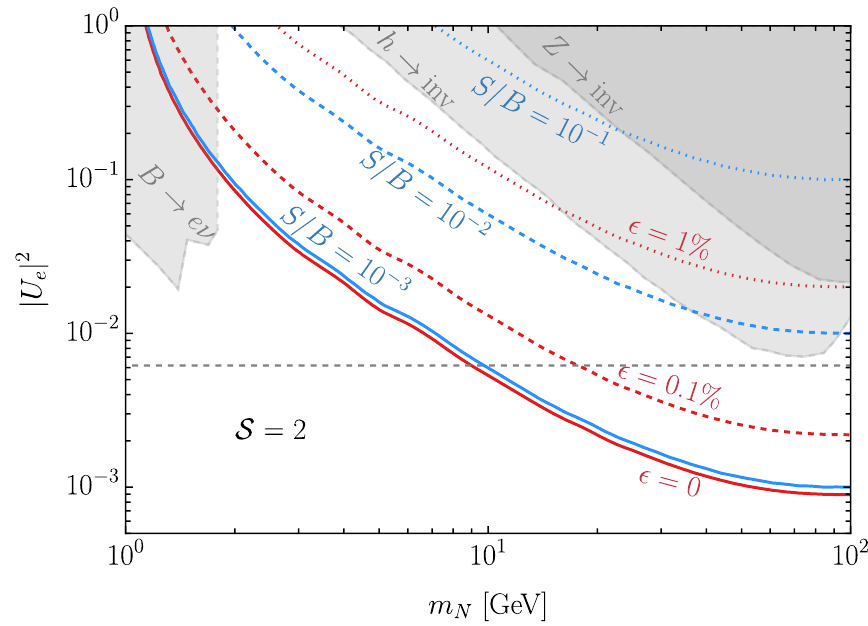
Figure 14 . The sensitivity probe (red lines) of the EIC based on the mono-jet search, quantified with S = 2 in eq. (4.12), with the relative systematic uncertainty as (cid:15) = 0 , 0 . 1% , and 1%. The existing bounds come from invisible decays of Z and Higgs bosons [1, 91], peak searches in B → eν decays [92] (gray shaded) and indirect constraints from precision electroweak observables (dashed line) [81]. Also shown are contours of signal-to-background ratios S/B = 10 − 3 , 10 − 2 , and 10 − 1 (light blue